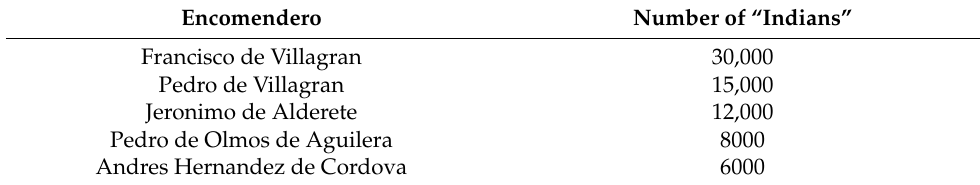
Table 1. The encomenderos of La Imperial. Source: Mariño de Lobera 1865. Encomendero Number of